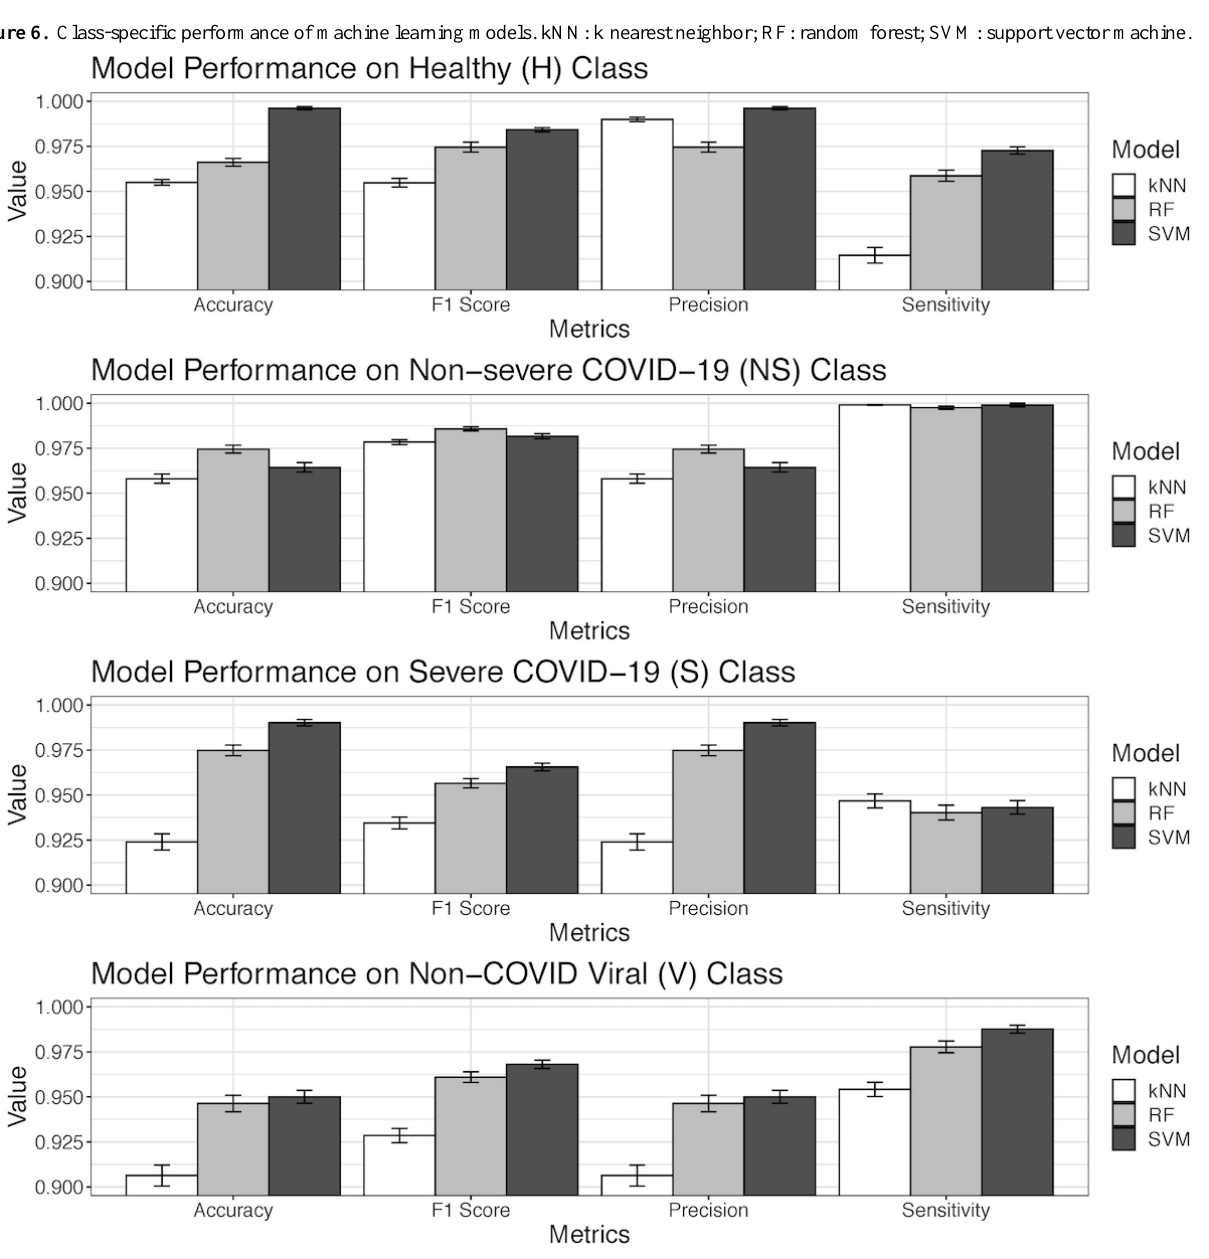
Figure 6. Class-specific performance of machine learning models. kNN: k nearest neighbor; RF: random forest; SVM: support vector